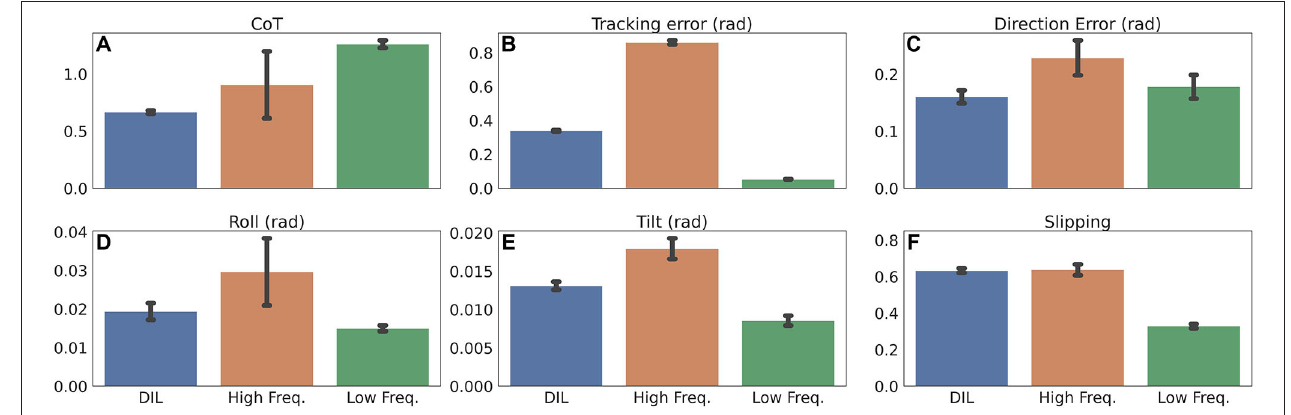
FIGURE 4 | Performance measurement when using online CPG frequency adaptation (DIL), a fixed high frequency, and a fixed low frequency. (A) The mean CoT. (B) The mean raw tracking error. (C) The mean heading direction error. (D) The mean roll of MORF. (E) The mean tilt of MORF. (F) The mean slippage. All measurements are shown with standard